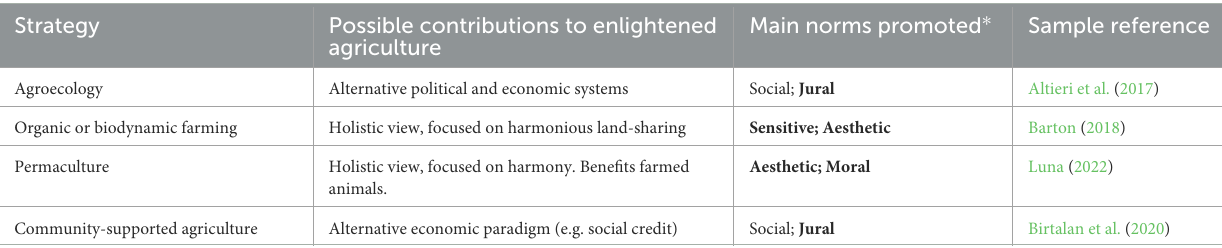
TABLE 2 Some visionary strategies for sustainable farming and how they might contribute to enlightened agriculture by addressing post-economic norms (bold font).